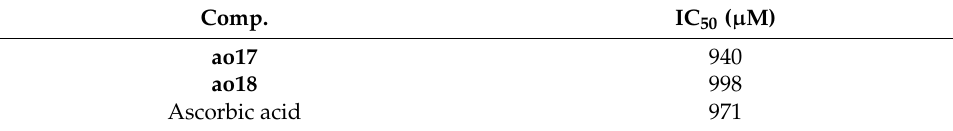
Table 62. In vitro antioxidant activity of the synthesized compounds (ao17 – ao18 ). Comp.